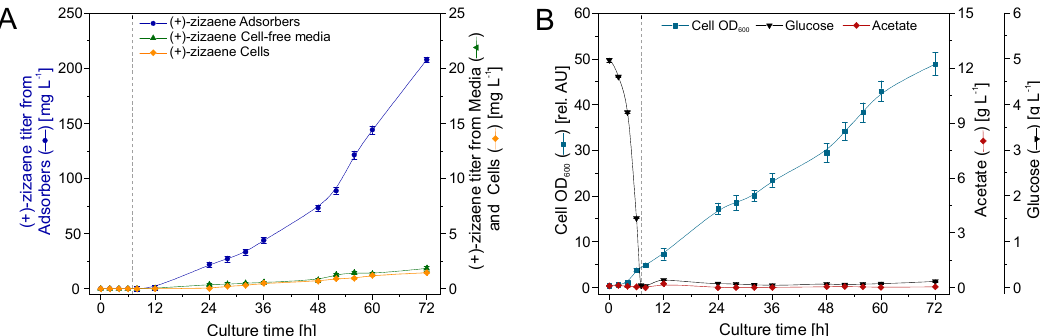
Figure 8. Production of (+)-zizaene ( A ) and growth kinetics ( B ) in 2 L bioreactor with internal recovery configuration (IRC). Dotted line indicates division between batch and fed-batch stages.